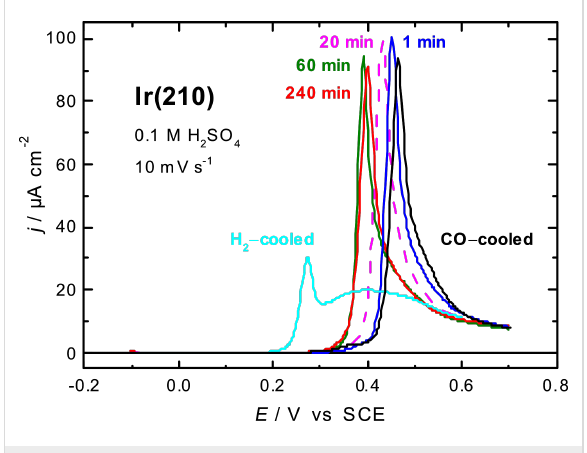
Figure 8: Current–potential curves for CO adlayer oxidation on Ir(210) in 0.1 M H 2 SO 4 before and after changing the surface morphology by potential cycling. Scan rate: 10 mV·s − 1